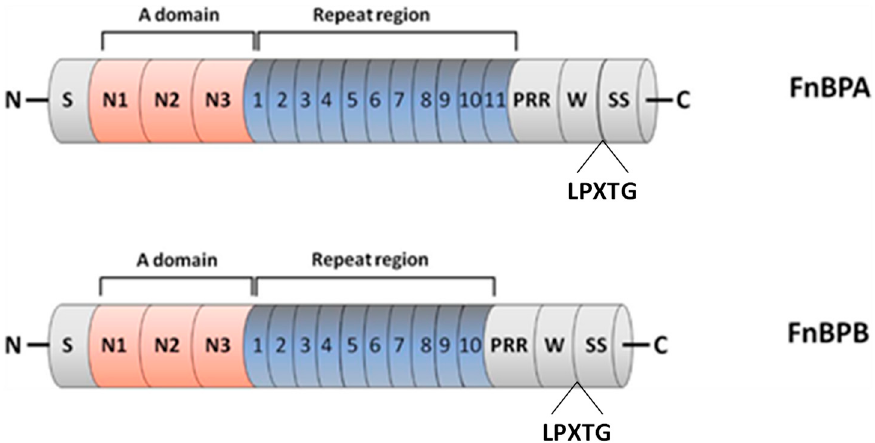
Figure 6. Domain organisation of FnBPA and FnBPB. From the N- to C- terminus, the FnBPs are composed of signal sequence (S), A domain with subdomains N1, N2 and N3, repeat region that is an unstructured region consisting of tandemly arranged motifs (11 in FnBPA and 10 in FnBPB), proline repeated region (PRR), wall-spanning (W) region, LPXTG motif (LPXTG) and sorting sequence (SS). Adapted with permission from O’Neill et al. [54]. 2008, American Society for